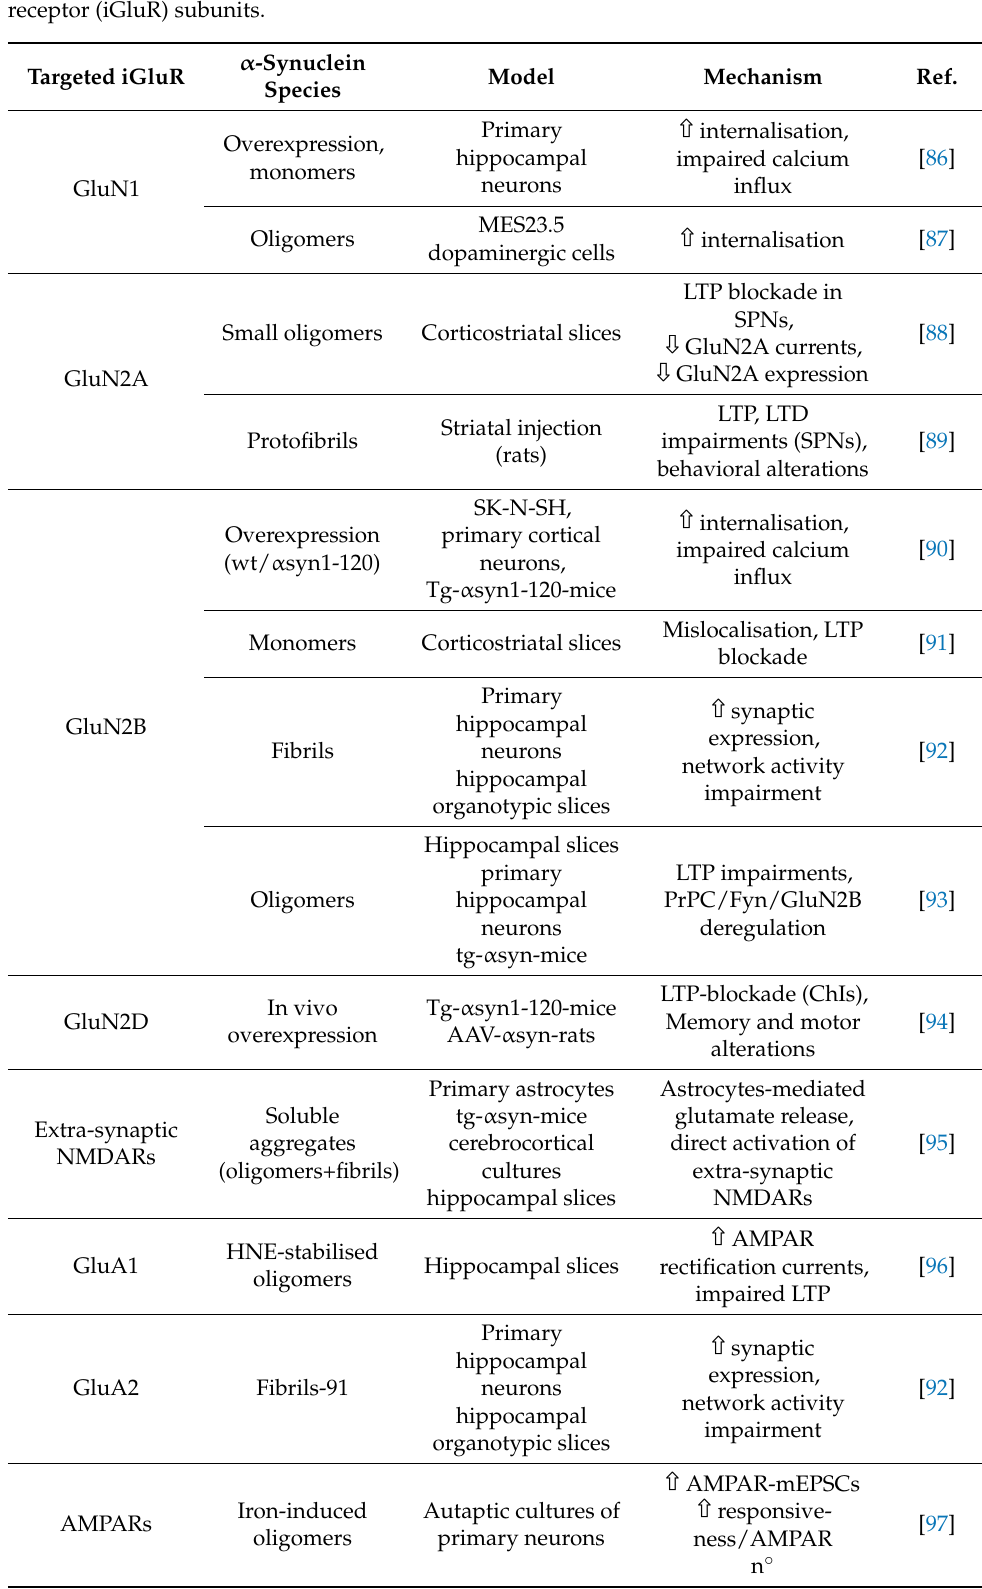
Table 1. Table reporting impact of different α -synuclein species on specific ionotropic glutamate receptor (iGluR) subunits.